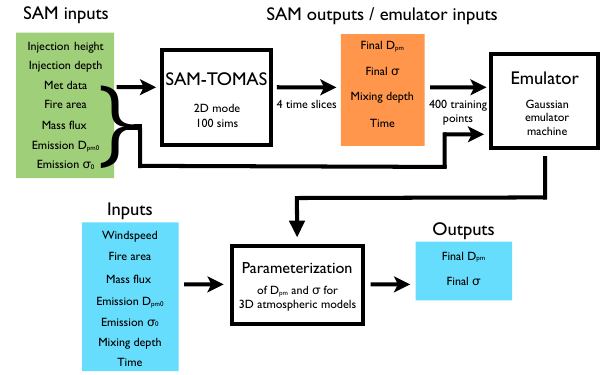
Figure 1. Schematic of the methods in this